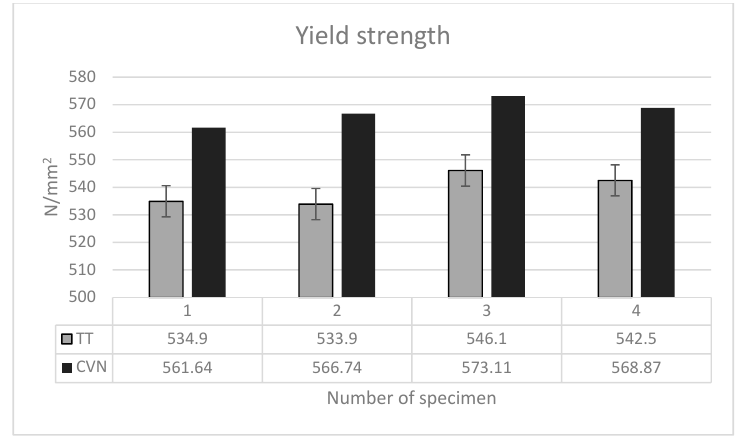
Figure 5. Yield strength comparison.